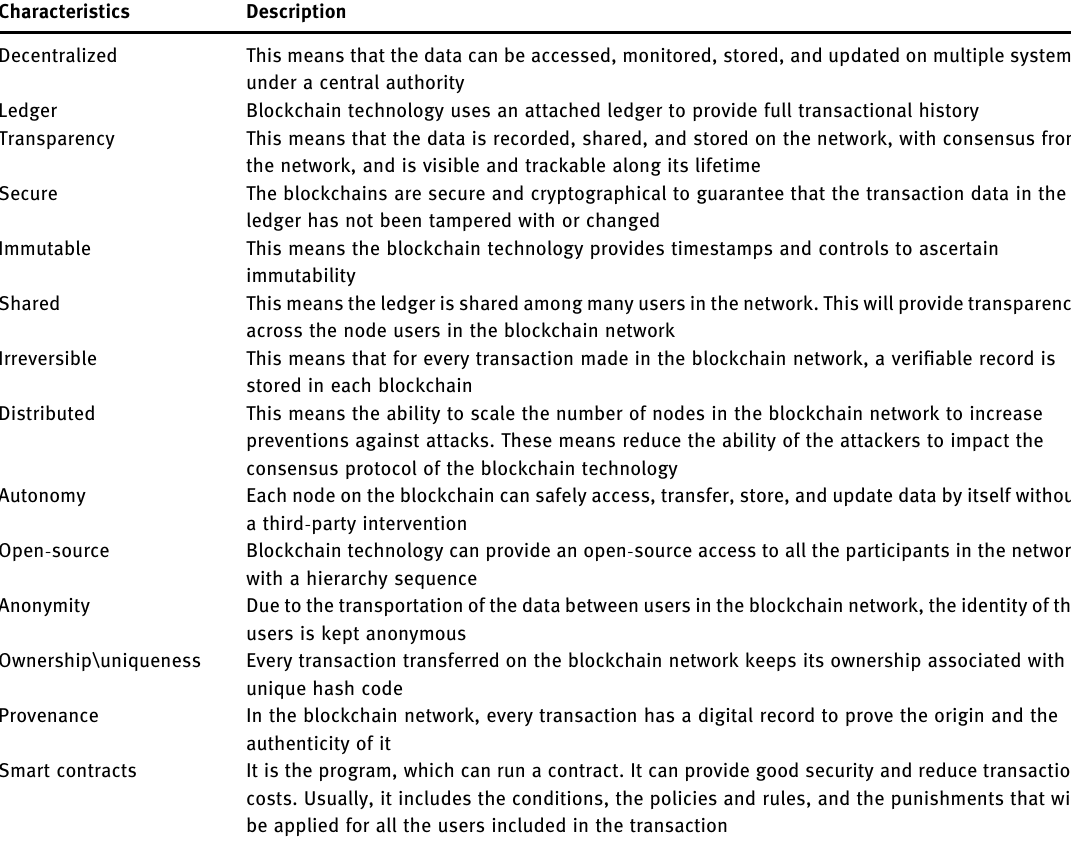
Table 1: Blockchain characteristics